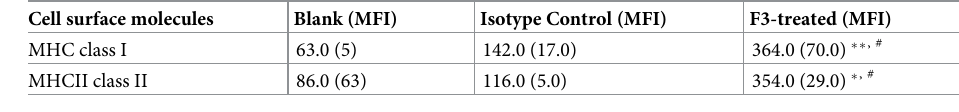
� p < 0.05 and �� p < 0.01 in comparison with vehicle control # p < 0.05 in comparison with isotype controls.